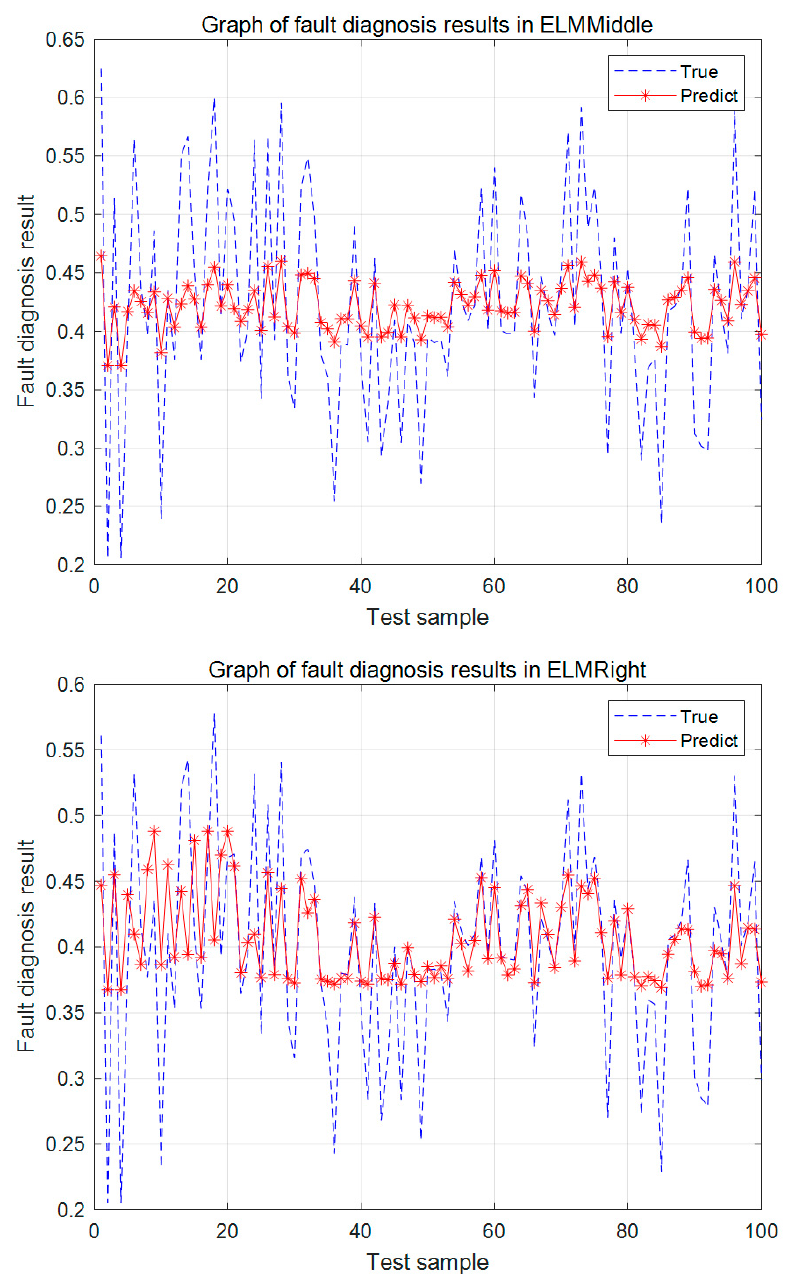
Figure 13. Fitting diagram of experimental results by ELM method.